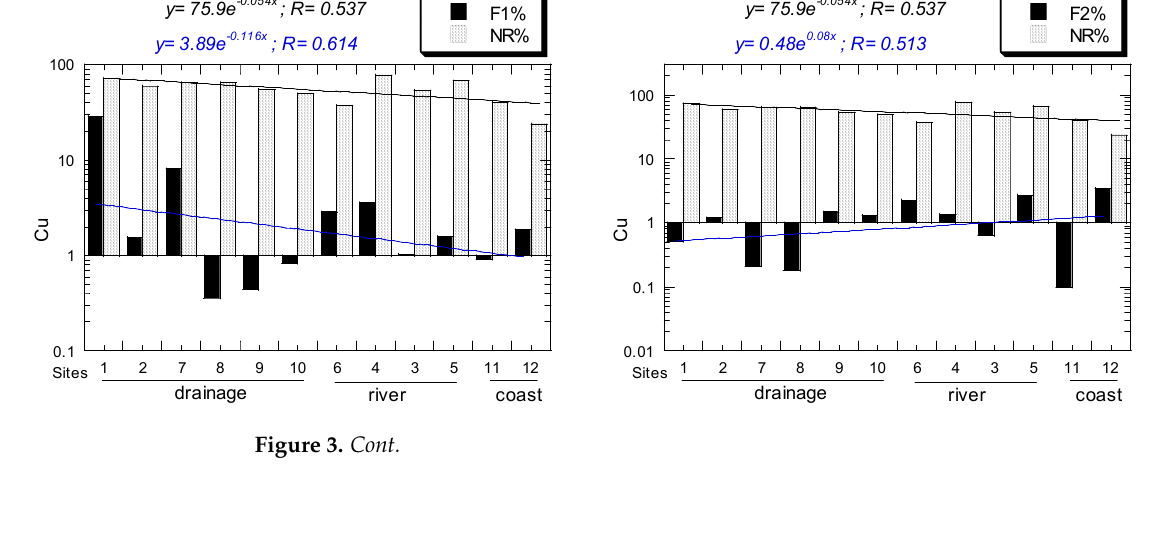
%), “oxidisable-organic” (F3; %), and non-resistant (%) fractions, ratios of non-resistant to resistant fractions (NR/R; unitless), enrichment factor (EF; unitless), geoaccumulation index (I geo ; unitless), contamination factor (CF; unitless), total Cd concentrations (Total Cd; mg/kg dry weight), and ecological risk (ER; unitless) of Cd. Note: hyphen (-) means minus.